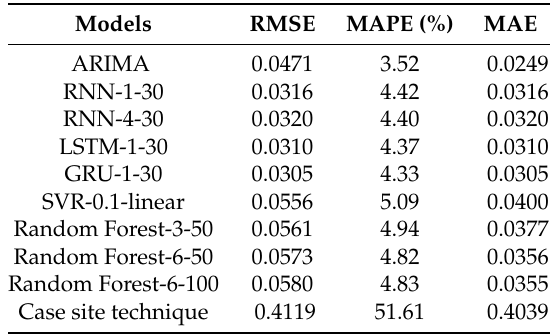
Table 3. RMSE, MAPE, and MAE results for the selected analysed